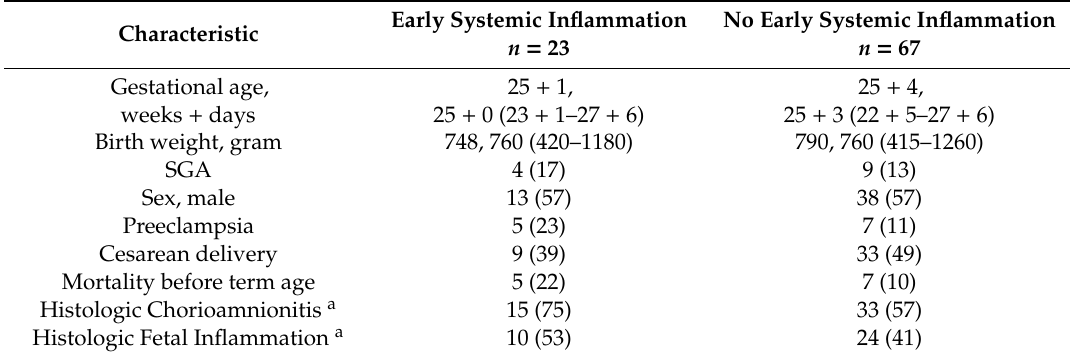
Table 1. Characteristics of the infants in the study cohort.